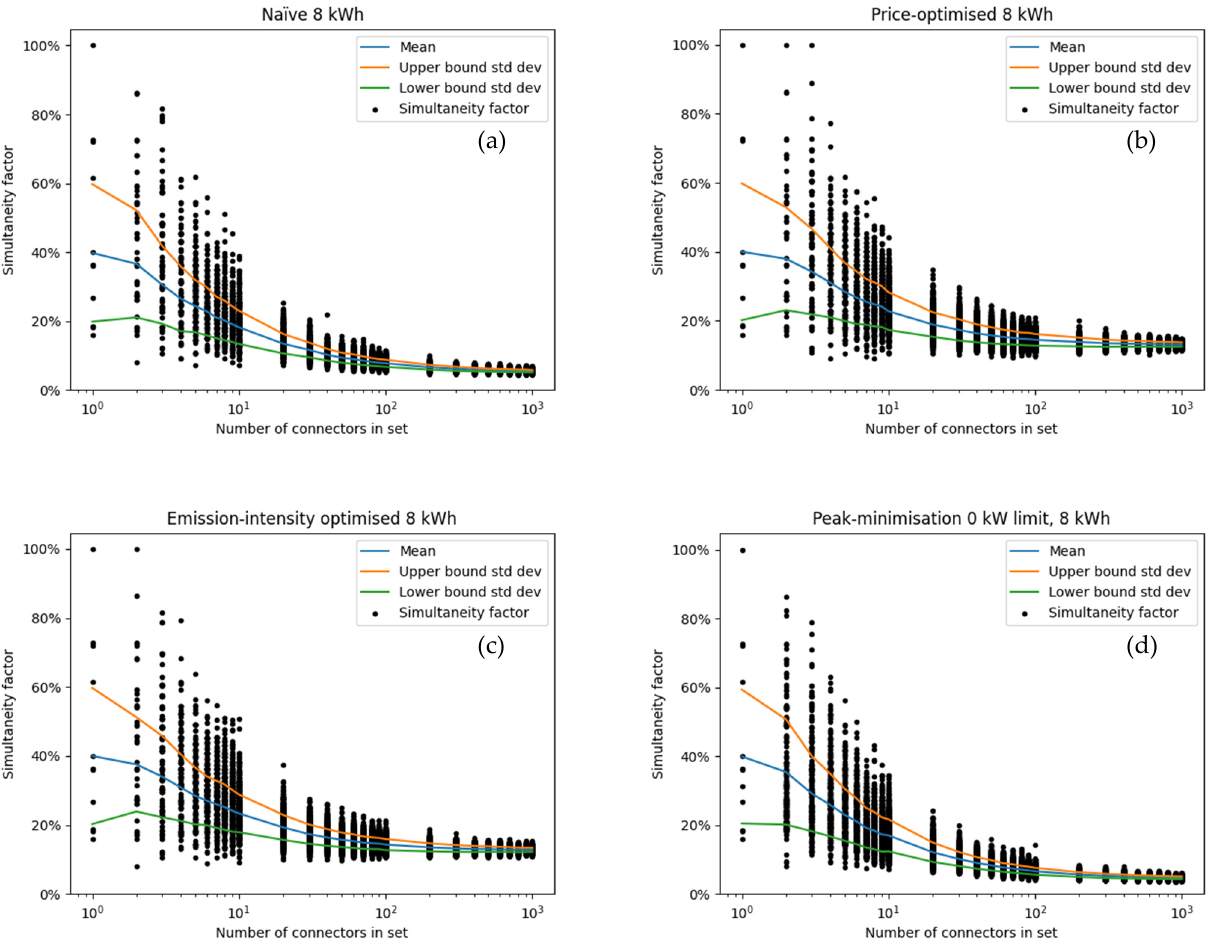
Figure A3. Coincidence factor assuming 8 kWh per CE for ( a ) naive charging; ( b ) price-optimised charging; ( c ) CO 2 intensity optimised charging; ( d ) peak power optimised charging. Note that peak power was optimised for all C simultaneously. Optimizing for each set in ( d ) for a low simultaneity factor likely results in significantly lower values. For the larger sets, the difference is minor. The blue line shows the mean across the randomly selected sets, and the orange and green lines the upper and lower boundaries of the standard deviation. Each randomly selected set was of the size shown on the x -axis.